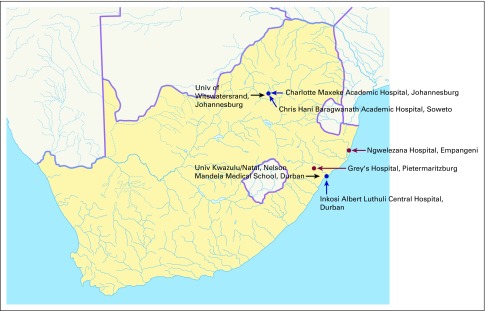
Locations of South African Breast Cancer and HIV Outcomes study sites.